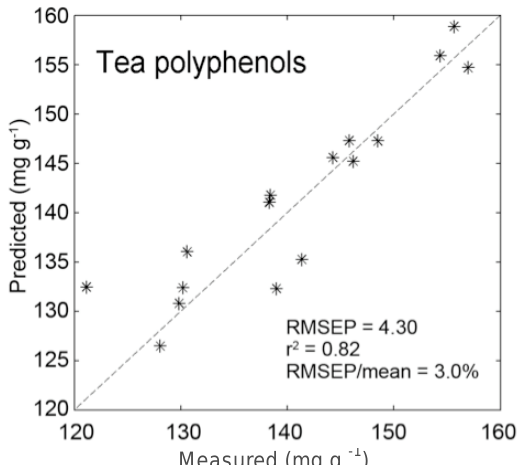
Figure 3. Relationships between the predicted and measured total tea polyphenols using a hybrid of neural networks and SPA variable selections, according to the test dataset (n=16).